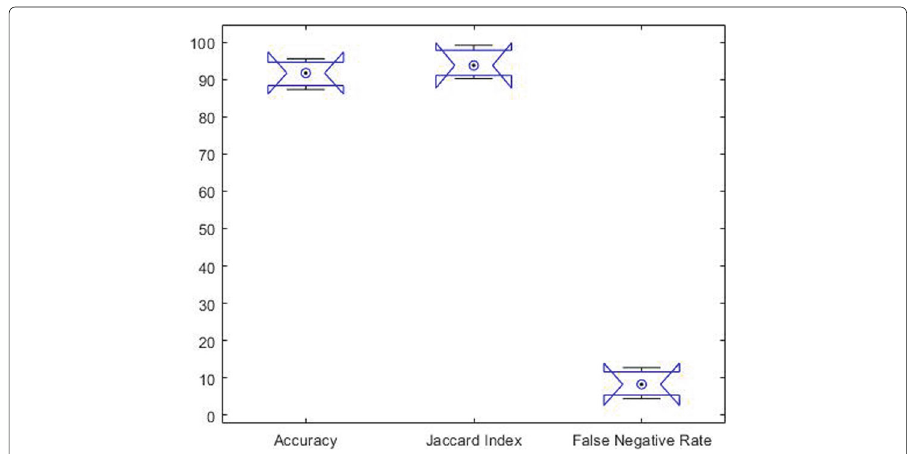
Fig. 12 Proposed average segmentation results plotted in the form of boxplots